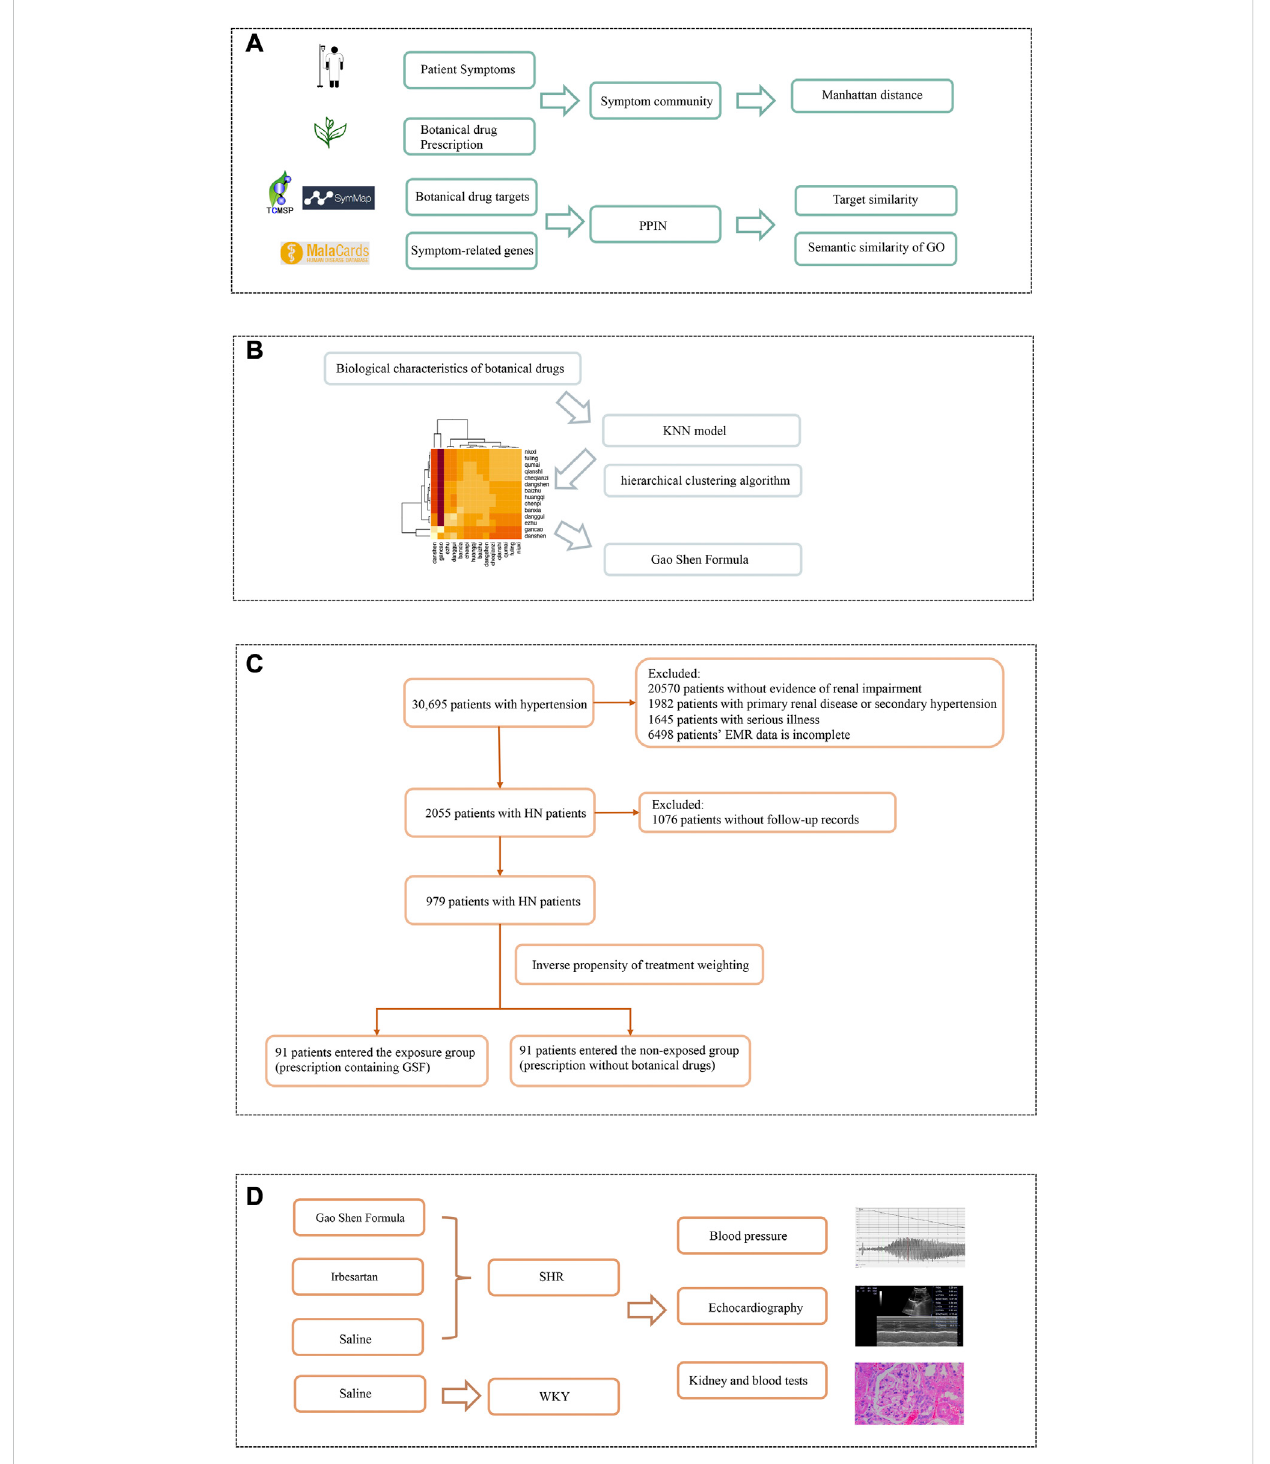
FIGURE 1 Work fl ow of botanical drugs screening and ef fi cacy veri fi cation. (A) Establishing symptom – botanical drug relationships. Based on the symptom network and protein – protein interaction network, we quanti fi ed the biological characteristics of botanical drugs. (B) Analysis of botanical drug characteristics. The KNN model was used to comprehensively analyze the biological characteristics of botanical drugs to form a correlation heatmap of theinteraction between botanical drugs. After hierarchical clustering algorithm screening, thecompositionoftheGao ShenFormulaisdetermined. (C) Regressioncohortvalidation.Wescreenedpatientsbasedontheinclusionandexclusioncriteria.Afterpropensityscorematching,theexposedgroup and the non-exposed group each included 91 patients. (D) Experimental model veri fi cation. We used Gao Shen Formula, irbesartan, and saline to receive SHR or WKY for 8 weeks, and observed the differences of blood pressure, echocardiography, kidney, and blood indexes in